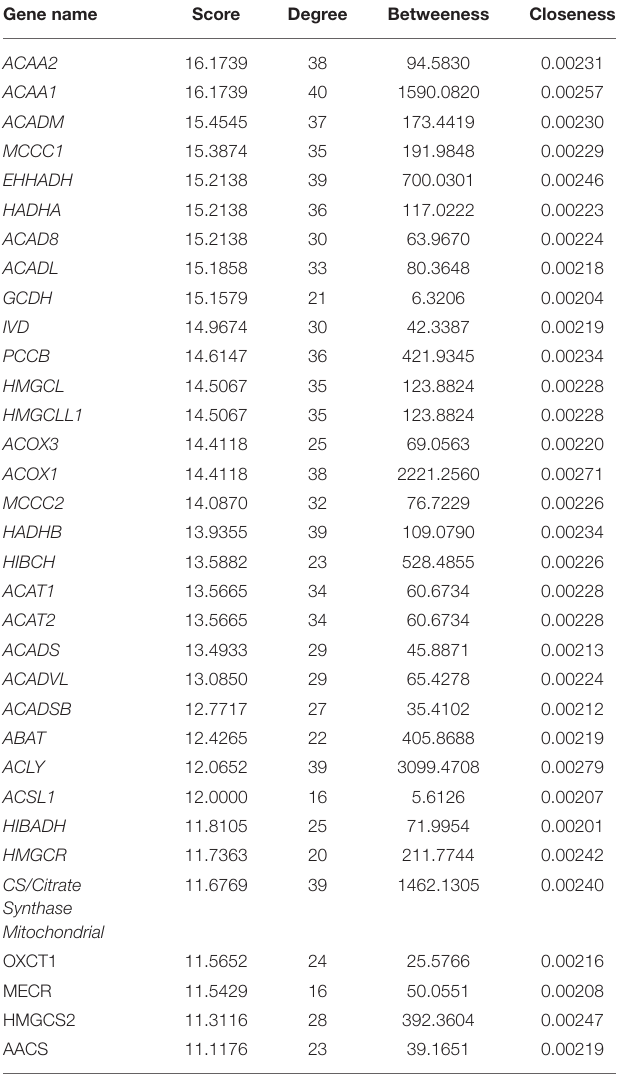
TABLE 4 | List of genes showing PPI scores > 10 identified through MCODE and